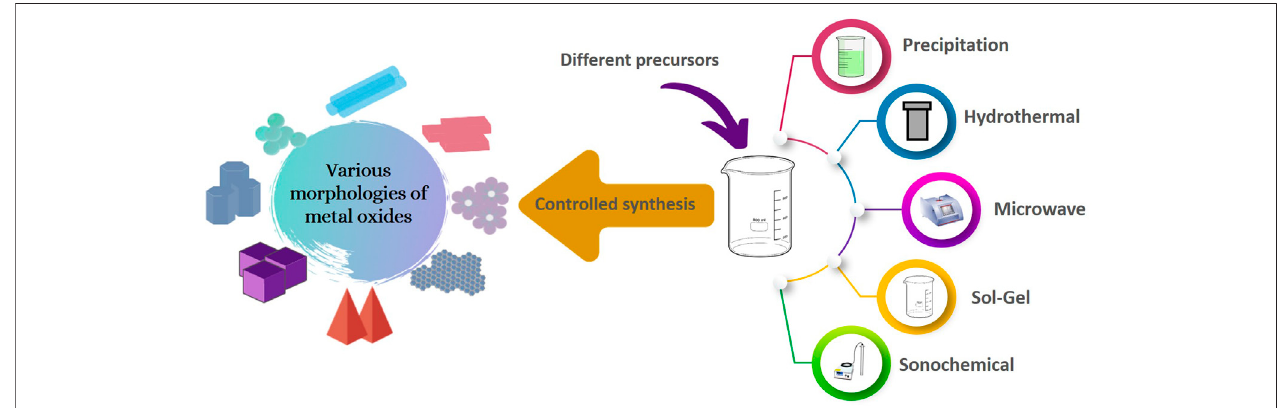
FIGURE 1 | Different morphologies of metal oxides synthesized using different precursors having different